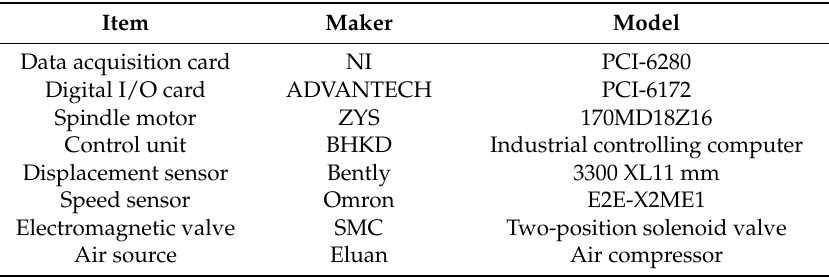
Table 4. Specifications of the experimental